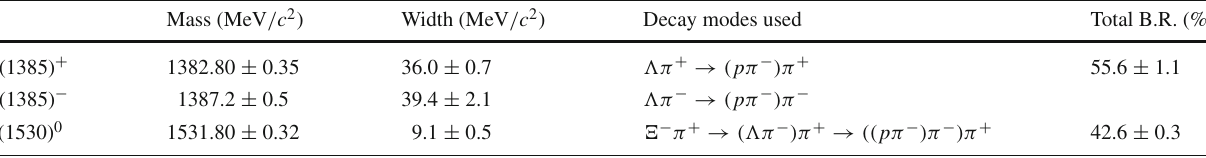
Table 2 Properties of the measured resonances and decay modes used in this analysis with total branching ratios [16], obtained as the products of respective branching ratios of daughter particles Mass (MeV / c 2 ) Width (MeV / c 2 ) Decay modes used Total B.R.